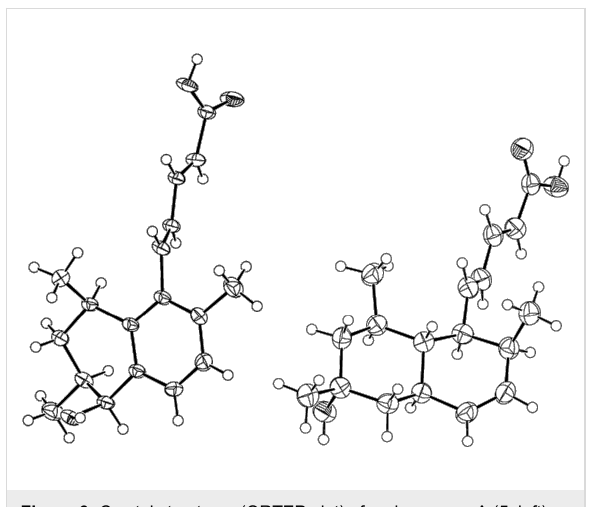
Figure 6: Crystal structures (ORTEP plot) of arohynapene A ( 5 , left) and tanzawaic acid E ( 8 , right). Thermal ellipsoids are drawn at the 50% probability